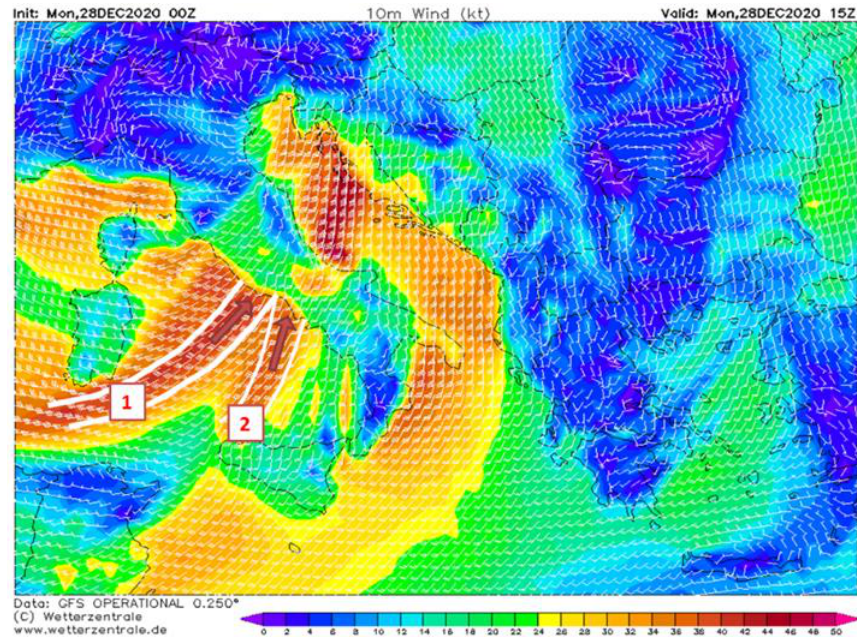
Figure 12. Meteorological map (GFS Operational 0.250°) valid on 28 December 2020-H05:00 UTC for 10 m wind (kt). There is chromatic evidence of winds with gale force. For explanation of 1 and 2 corridors see the main text. Downloaded by www.wetterzentrale.de, accessed on 6 September 2021. Corridor 1 is relatively wide and is characterized by high speed, SW winds,